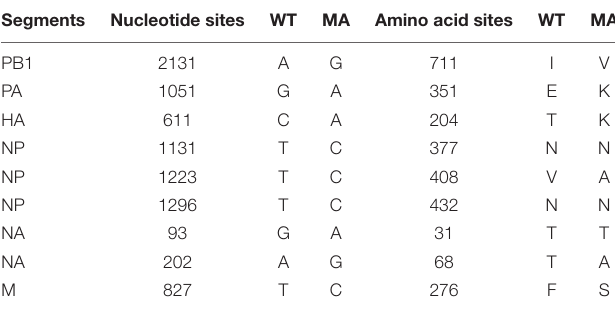
TABLE 2 | Nucleotide and amino acid differences between the wild-type (WT) H9N2 strain and the mouse-adapted (MA) H9N2 strain. Segments Nucleotide